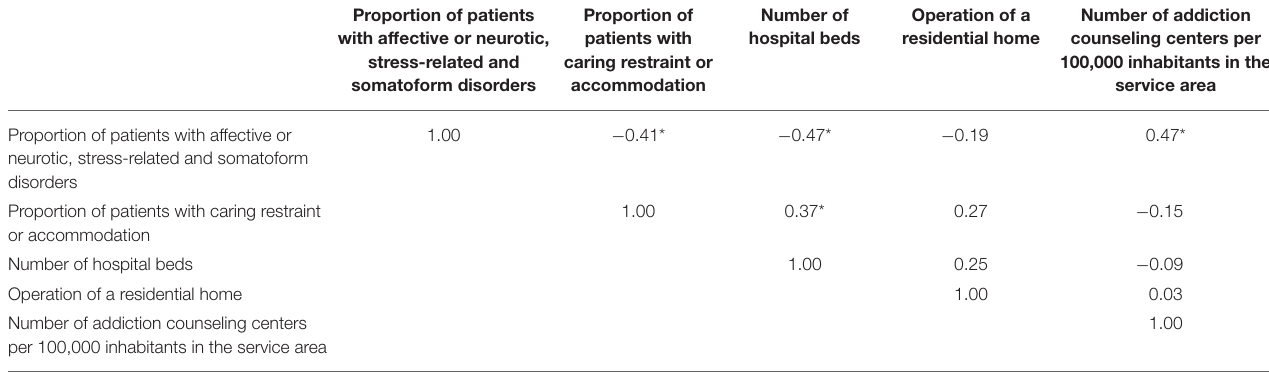
TABLE 3 | Intercorrelations of possible predictors.